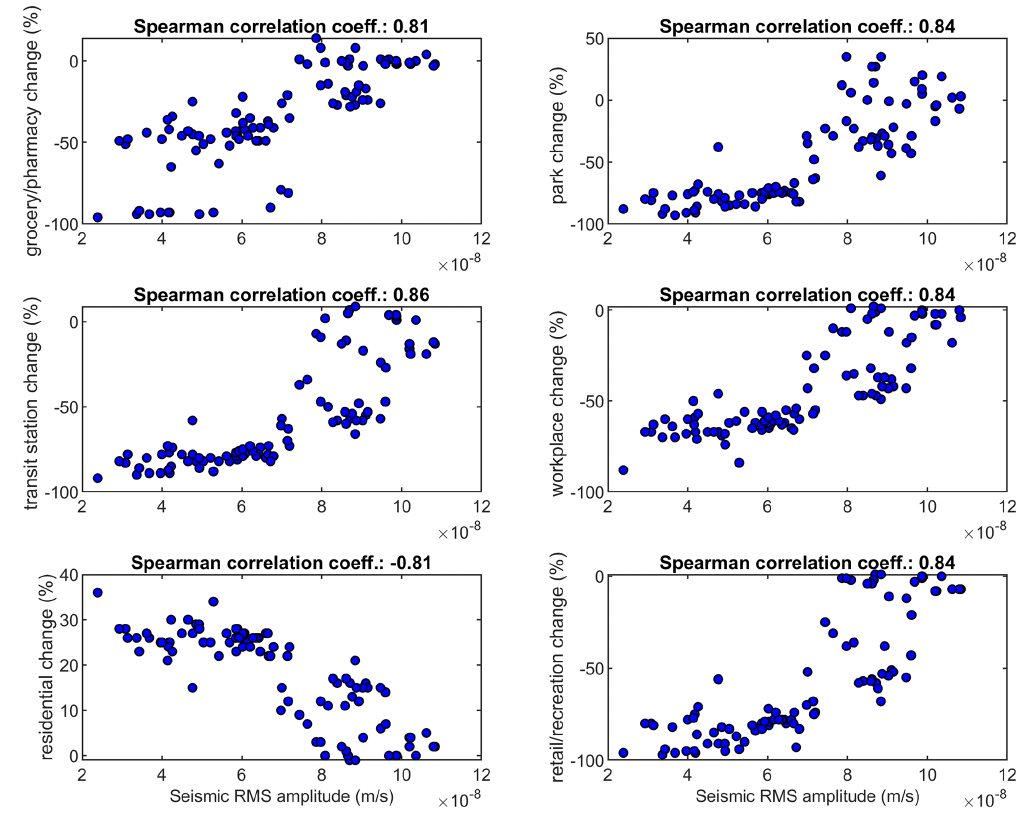
Figure A2. Cross plots showing the seismic rms amplitude of EFIU station in the band 10–40Hz in the x axis and the different categories of human mobility from Google in the y axis from 15 February to 20 May 2020. The values of the Spearman correlation coefficient, computed between the time series plotted in the graph, are shown in the